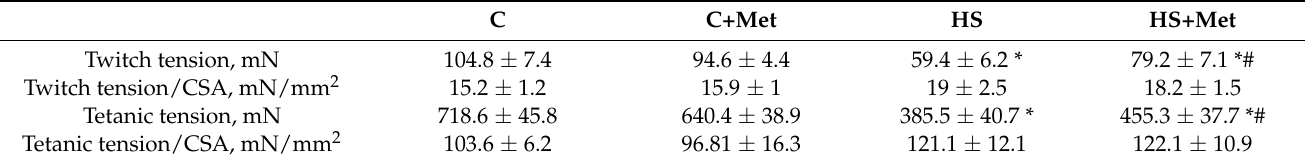
C, #: p < 0.05 vs. HS. CSA, muscle cross-sectional area.